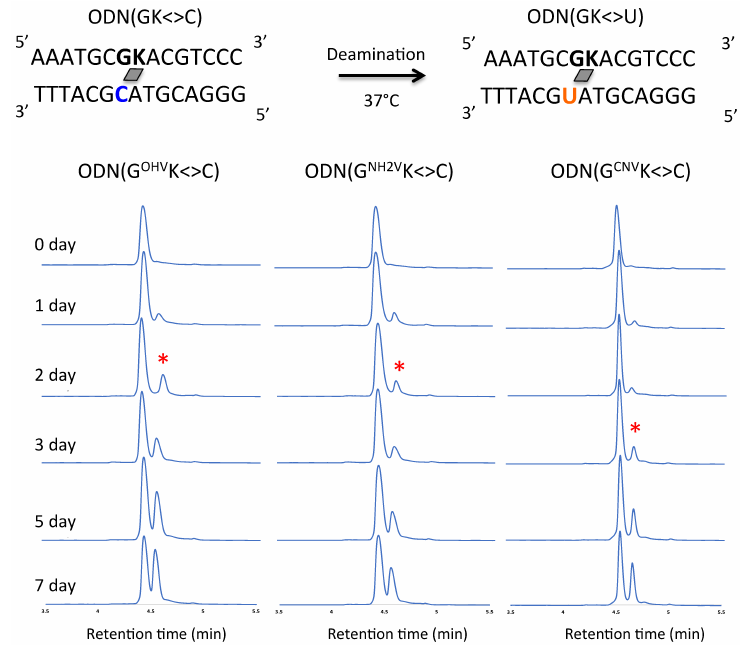
Figure 4. UPLC analysis of the deamination reaction of the photo-cross-linked duplex consisting of ODN(GK) and cODN(C). [ODN(GK<>C)] = 5 µ M in 50 mM Na-cacodylate buffer (pH 7.4) containing 100 mM NaCl. incubated at 37 ◦ C, photo splitting was performed with transilluminator (312 nm) at 37 ◦ C. Peak marked with asterisk ( * ) indicate the newly formed ODN(U).